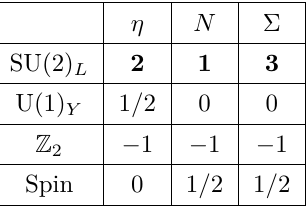
Table 1 . New particle